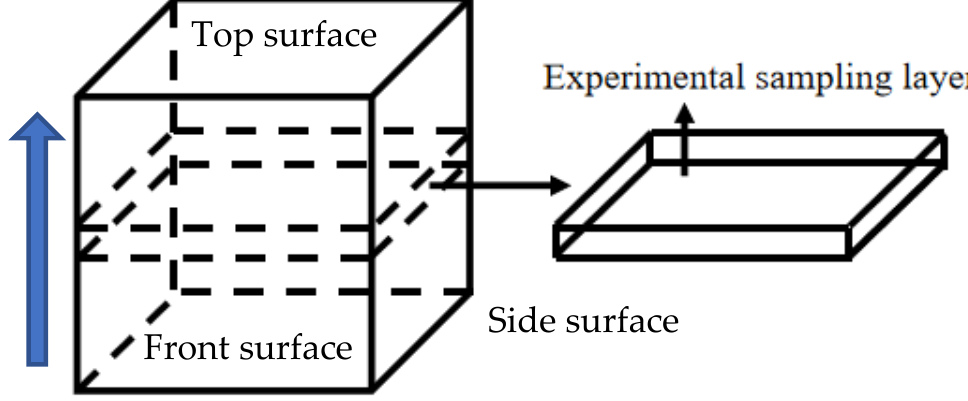
Figure 2. Schematic diagram of experimental sampling layer